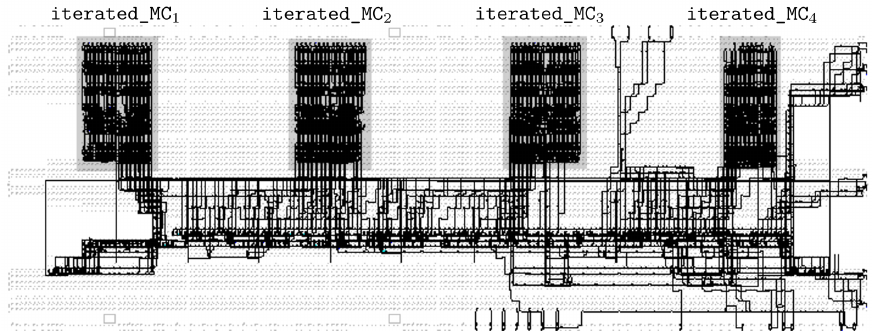
Figure 3: The floorplan of the target FPGA in case study 1 (rotated counter clockwise) 3